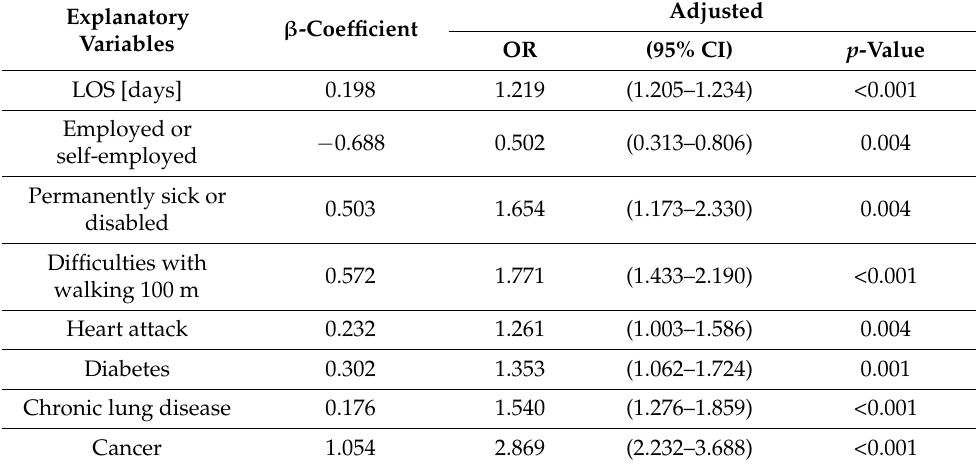
Table 5. Multivariate analysis of factors associated with cost